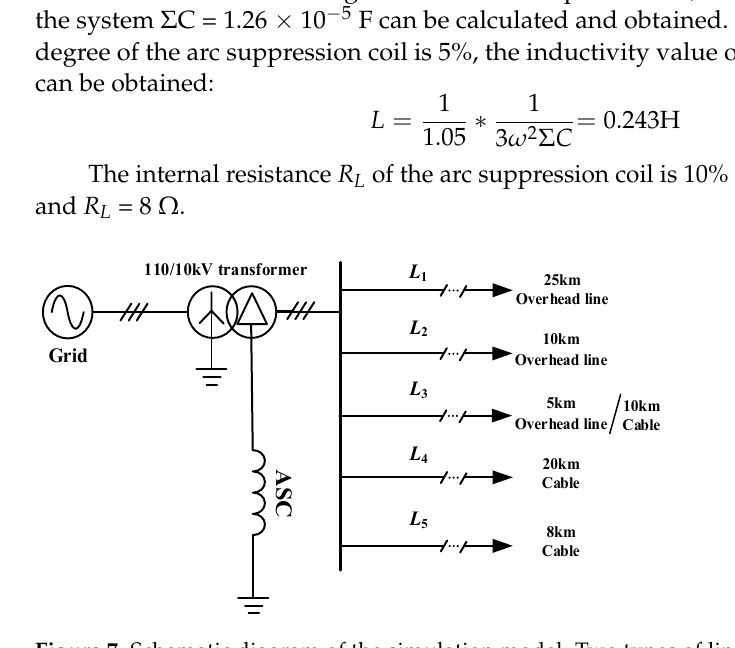
Figure 7. Schematic diagram of the simulation model: Two types of lines are considered. Table 1. Line parameters.